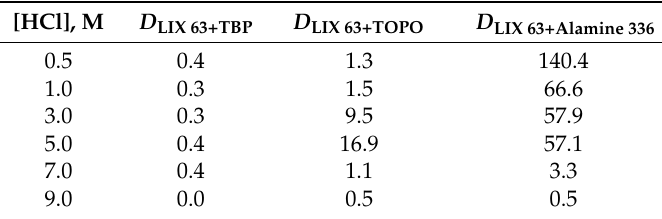
Table 7. Distribution ratio of Pd(II) with 5,8-diethyl-7-hydroxyldodecane-6-oxime (LIX 63) + TBP, LIX 63 + trioctylphosphine oxide (TOPO), and LIX 63 + Alamine